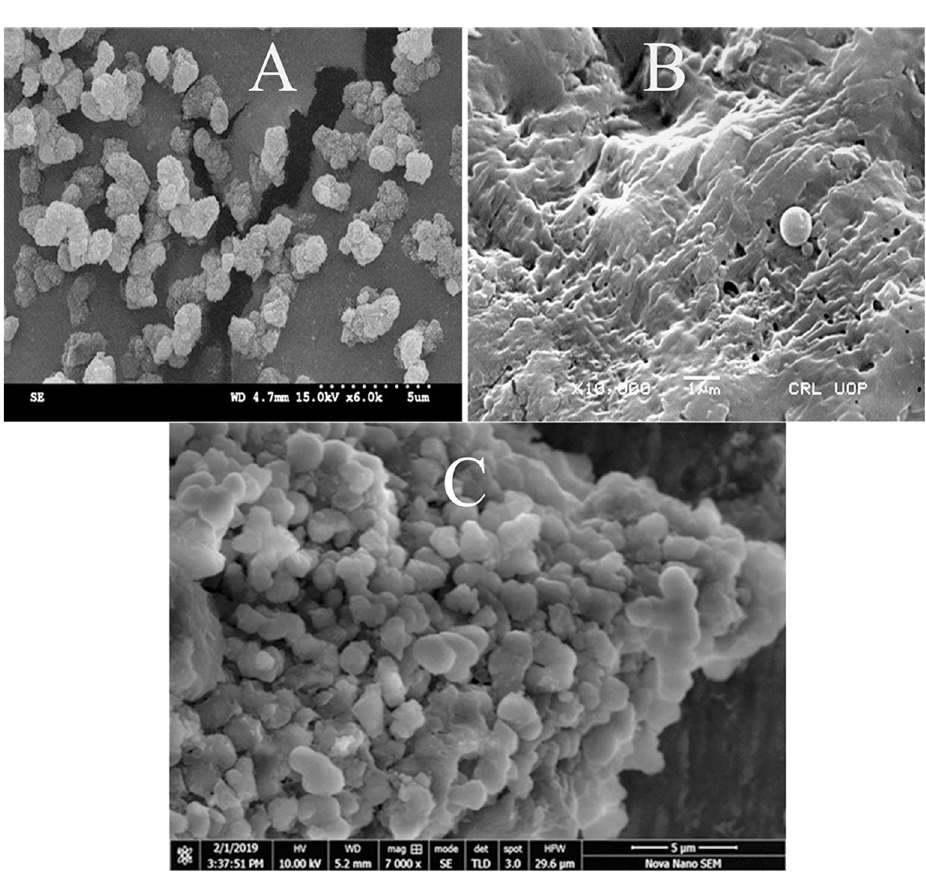
Figure 5. The FE-SEM images of Silica monolith ( A ), Graphene oxide ( B ), Silica anchored Graphene oxide composite ( C